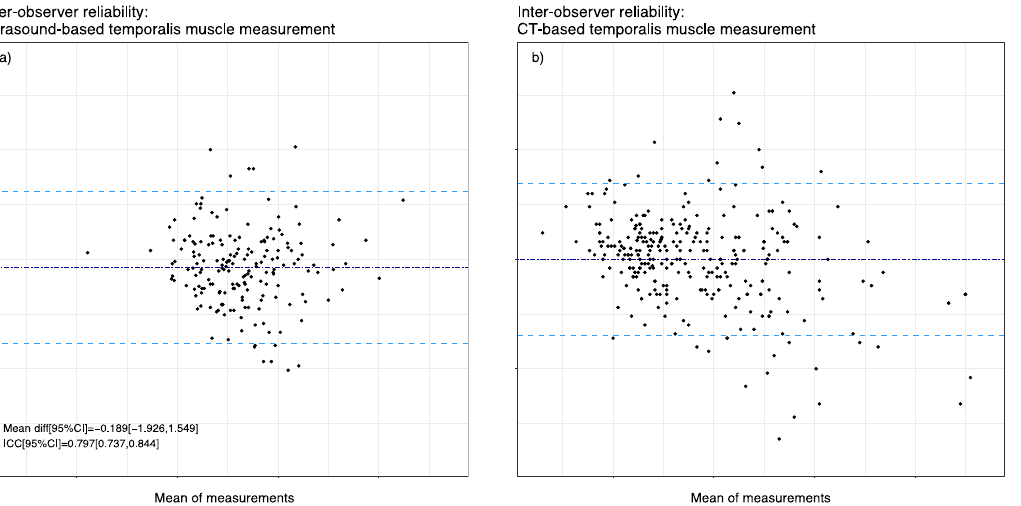
Figure 3. Inter-observer reliability between the two measurement techniques. Bland Altman repre- sentation with mean differences (dark blue dashed line) and 1.96 SD limits (light blue dashed lines). ( a ) Inter-observer reliability of ultrasound-based TMT measurements. ( b ) Inter-observer reliability of CT-based TMT measurements.